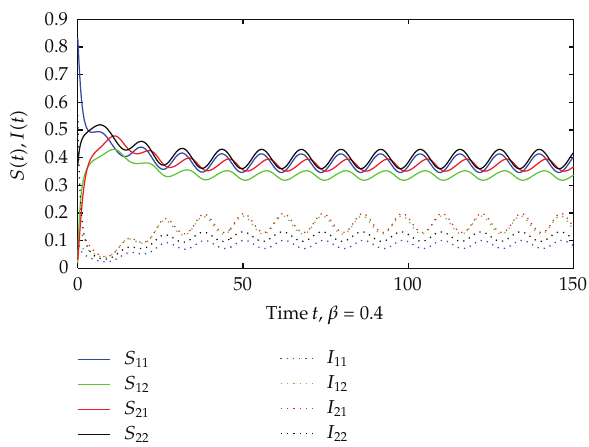
Figure 1: When R 0 > 1, a positive periodic solution exists and the disease will be uniform persistence.